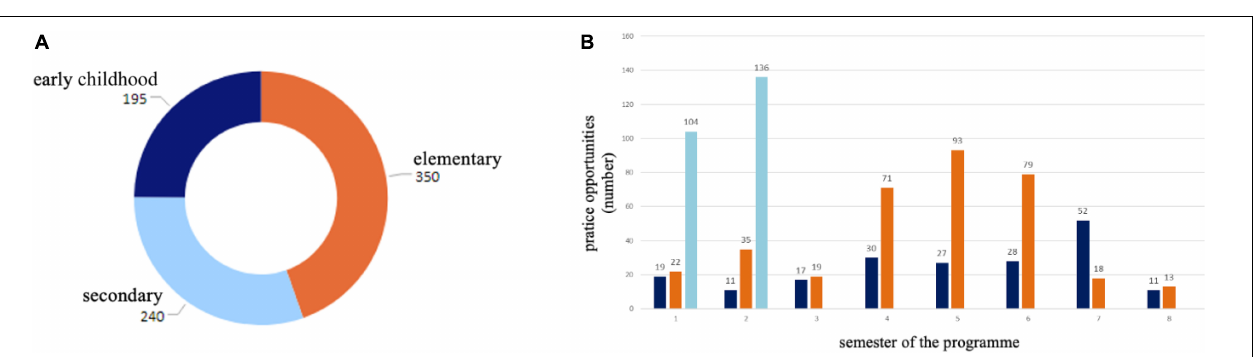
FIGURE 2 | Frequency of practice opportunities in learning activities planned to be performed during on-campus coursework, by program (total) (A) and semester of the program (absolute number) (B) .